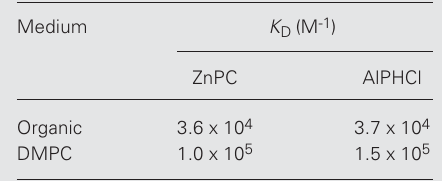
Table 1. Dimerization constants of ZnPC and AlPHCl at 25 º C in organic solution and DMPC